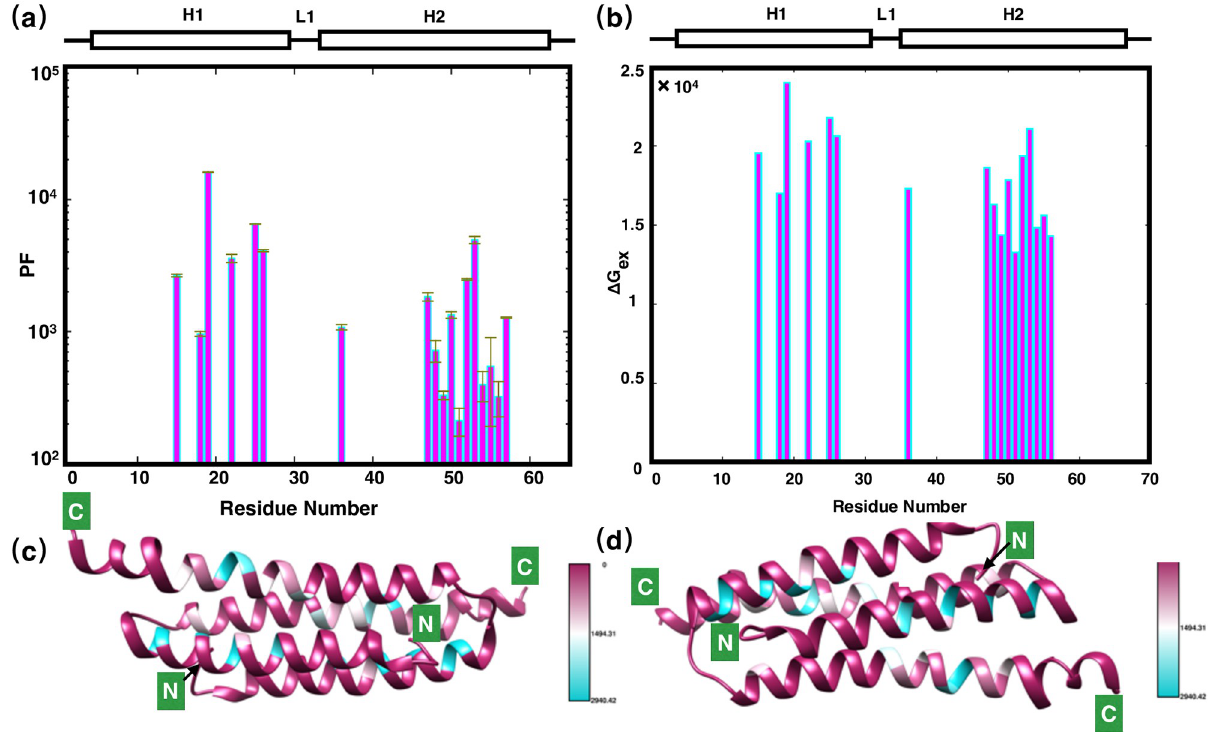
Fig 5. H/D exchange of PRC1-DD. (a) Bar graph showing the protection factor of each amide proton in PRC1-DD, schematic representations of PRC1-DD structure were also provided on top of the figure. (b) Bar graph showing the unfolding free energy ( Δ Gex ) of each residue. (c) Experimentally determined free energy of unfolding ( Δ Gex ) mapped to PRC1-DD solution structure. The Δ G medium exchangers (white) Δ G ex = 15000–30000; slow exchangers (cyan) Δ G ex � 15000. Figures were drawn using CHIMERA.